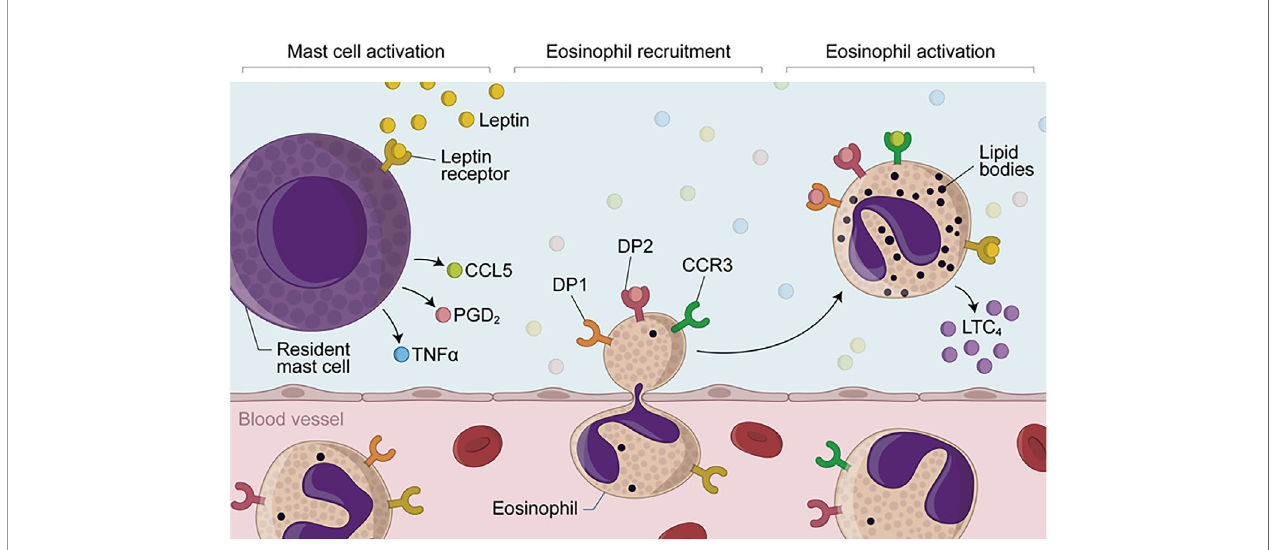
FIGURE 7 | Proposed mechanisms of leptin-induced in vivo eosinophilic in fl ammation mediated by mast cell-derived PGD 2 . Eosinophilic in fl ammation triggered by in vivo stimulation with leptin depends on sequential events, including (i) initial activation of resident mast cell secretory activity; (ii) increased local levels of TNF a , CCL5 and PGD 2 ; (iii) induction of eosinophil migration by TNF a and PGD 2 and then; (iv) cellular activation of recruited eosinophils, characterized by lipid body biogenesis and LTC 4 synthesis. While mast cell-derived PGD 2 may induce eosinophil in fl ux via activation of its chemotactic DP2 receptor which is highly expressed on eosinophils, leptin-driven in situ eosinophil activation is mediated by both CCL5 and PGD 2 throughout simultaneous activation of CCR3 and PGD 2 receptors DP1 and DP2 — whose downstream signaling are known to culminate with in vitro lipid body-compartmentalized synthesis of LTC 4 within leptin-stimulated